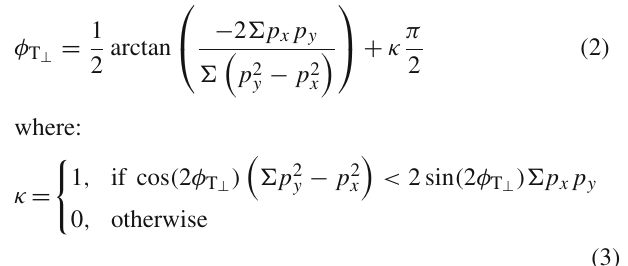
Fig. 1 The average number of jets per event ( (cid:3) N Jet (cid:4) ) as a function of H T . The result is stable under a change of the minimal transverse momentum and maximal pseudo-rapidity for jet acceptance. The lower average jet multiplicty exhibited by Madgraph and Powheg trijet may be attributed to the QCD scale uncertainties (not shown) and requires further investigation